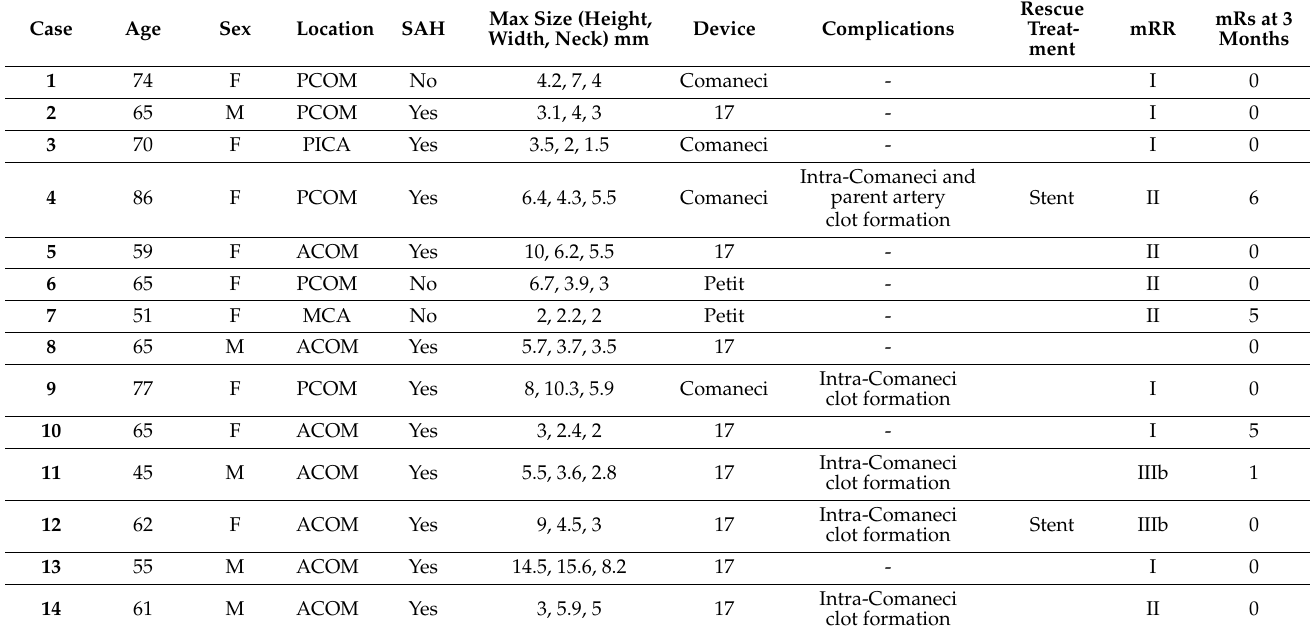
Table 1. Patients ordered chronologically. Demographic characteristics of the patients and aneurysm characteristics, device used, and operative outcome are displayed. ACOM—anterior communicating artery; PICA—posterior inferior cerebellar artery; MCA—middle cerebral artery; PCOM—posterior communicating